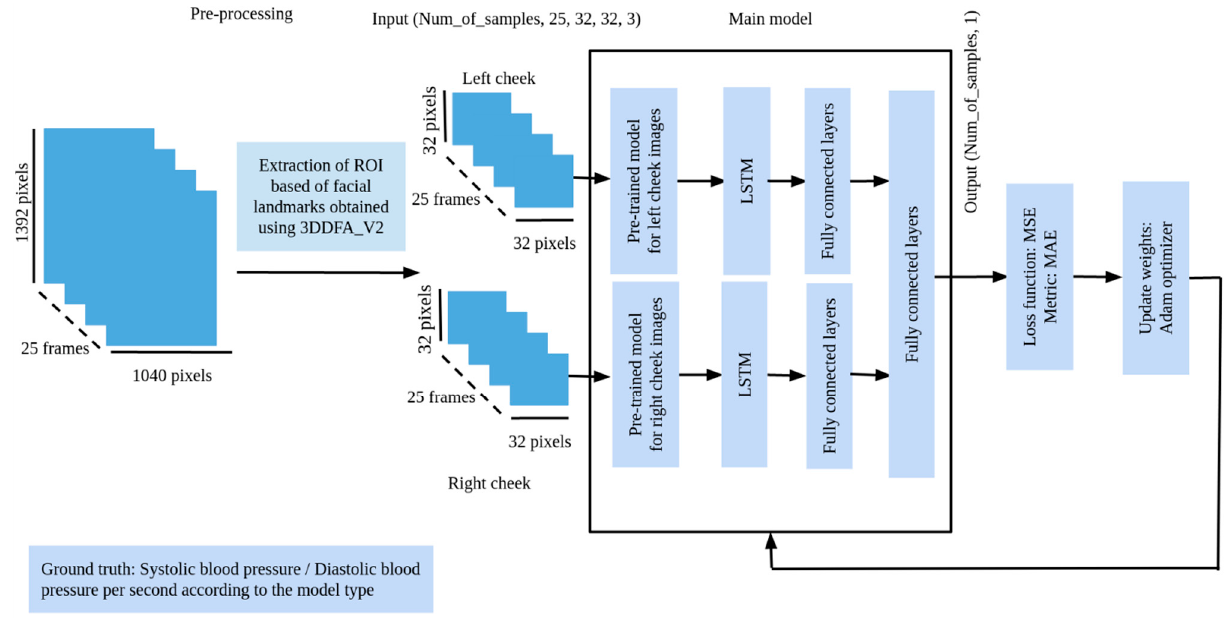
Figure 4. The overall structure of the training process.